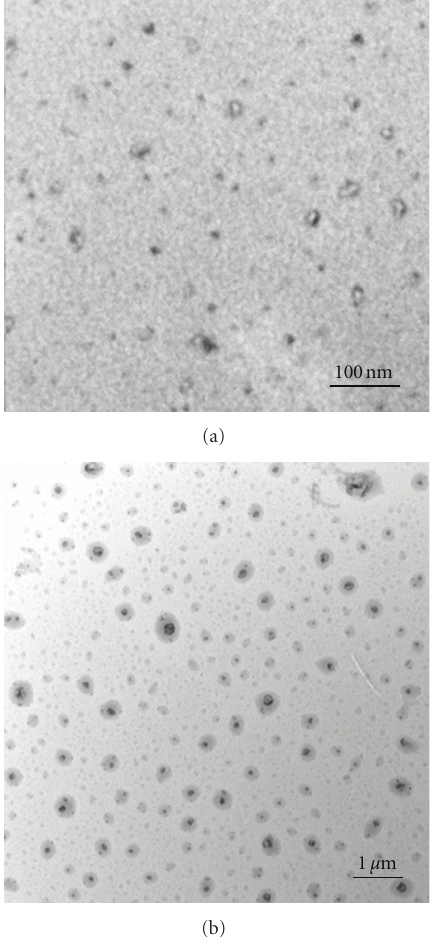
Figure 6: TEM images of micelles formed from copolymer 9 by dialyzing (against water) THF/water suspensions of the micelles containing (a) 2.5 vol% THF and (b) 40 vol%